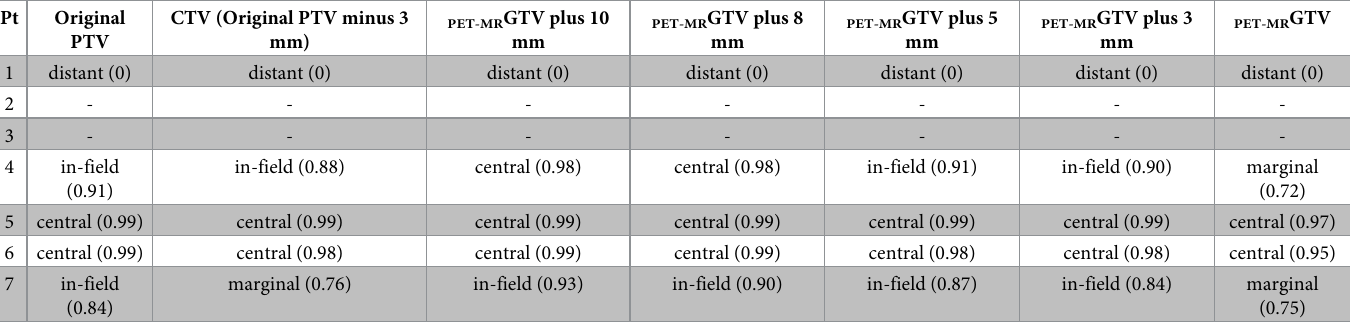
Table 3. Recurrence pattern analysis. Recurrence pattern in relation to original planning target volume, clinical target volume (original PTV minus 3 mm margin) and union of biological tumour volume with consensus gross tumour volume with a margins of 10, 8, 5 and 3 mm and without a margin; percentage of overlap with the volume of tumour recurrence in